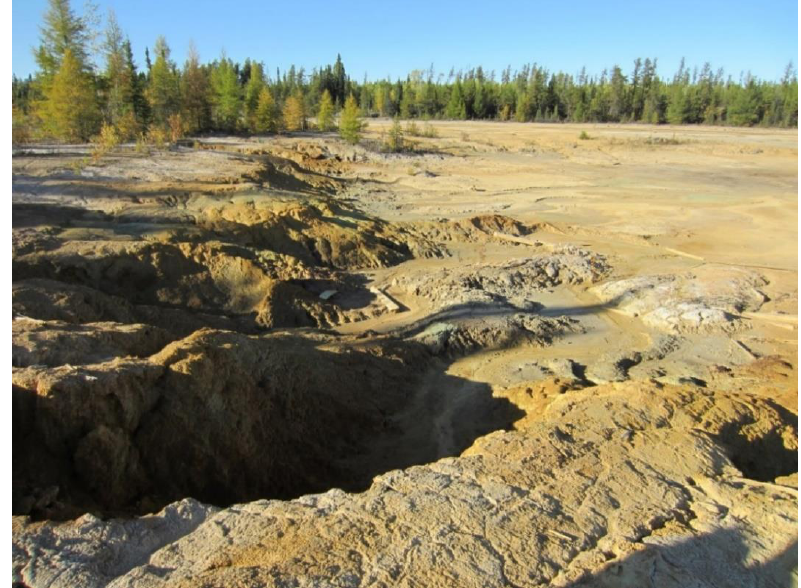
Figure 4. Gold mine tailings of the Central Mine, Nopiming Provincial Park, Manitoba, Canada. (Archives of V. Yurkov laboratory. Used with permission).